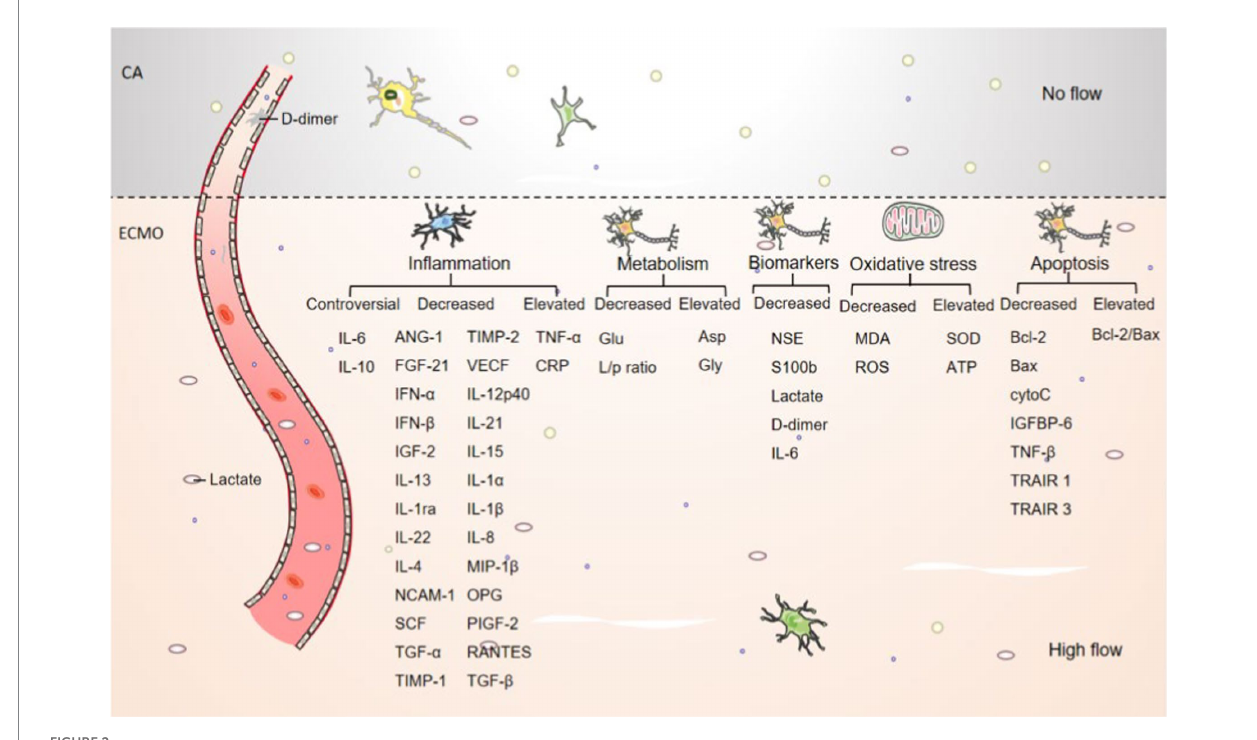
FIGURE 2 Schematic representation of the cerebral effects of ECMO. The number of brain neurons and nissls was elevated after ECMO resuscitation compared to CA. The number of lactate and d-dimer was decreased after ECMO resuscitation compared to CA. and other inflammatory, metabolic, necrotic, oxidative stress, apoptotic and other cytokine trends are shown in